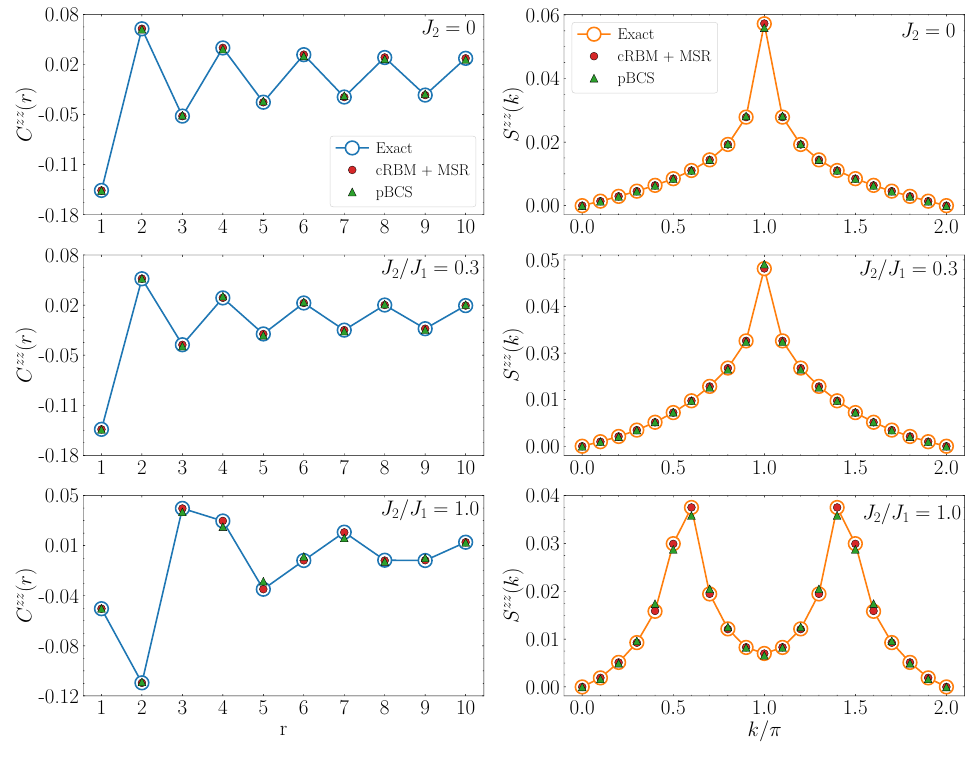
Figure 10: Spin-spin correlation function C zz ( r ) (left panels) and S zz ( k ) (right pan- / J els) for different values of J and N = 20 sites. Results for the best cRBM wave 2 1 = 1 (full circles), the pBCS state (full triangles), and the exact function with α c ground state (empty circles) are